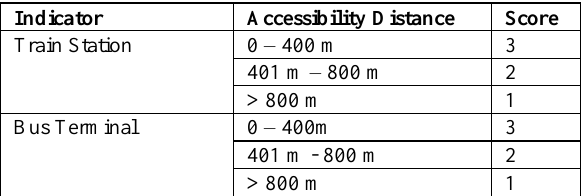
Table 3: The radius distance accessibility between